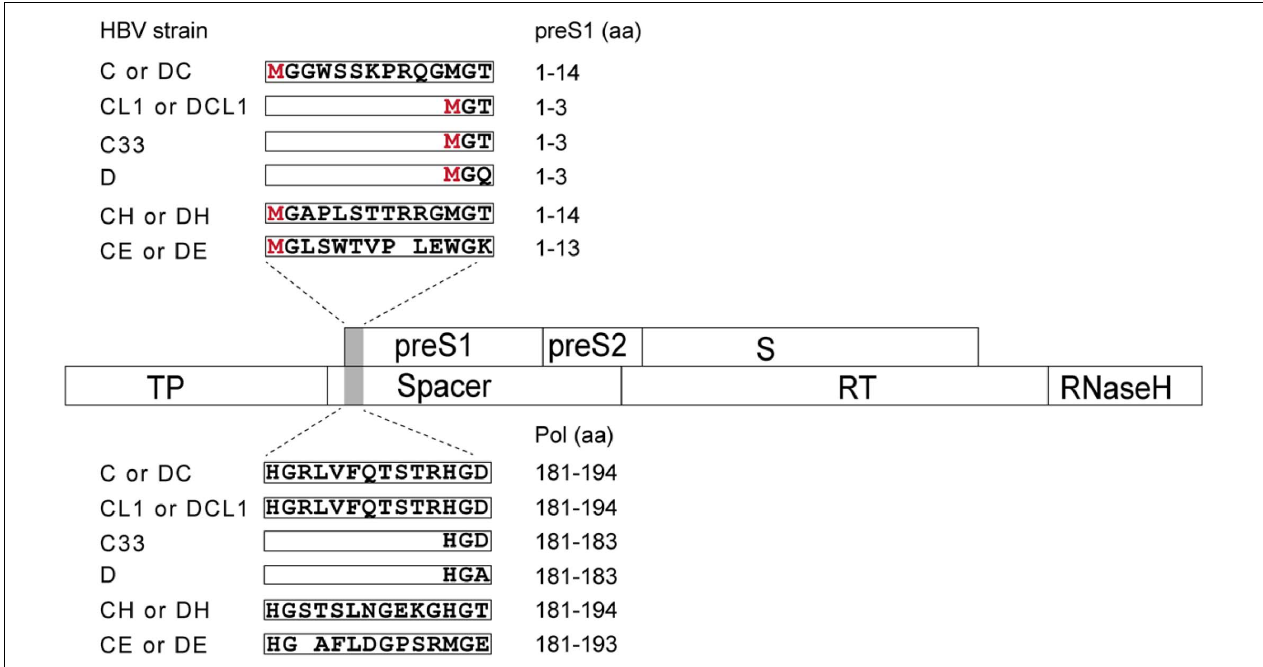
FIGURE 2 | Schematic representation of preS1 N-terminal sequences from C strain (GTC) or D strain (GTD) and their mutants in this study. Overlapping feature is showed between preS/S and Pol ORFs, which are indicated by open boxes. Mutated region is shaded by gray color. N-terminal sequences of preS1 are translated on the top in open boxes and corresponding Pol-spacer sequence are translated below. CL1 represents the C strain with mutated L1 from ATG into ACG, which shortens N-terminus of preS1 but changes no aa in spacer. C33 represents C with 33 nt deletion corresponding to 11 aa deletion at N terminus of preS1, which deletes 11 aa in both preS1 and spacer. CH and CE represent C with preS1 N-terminus substitution with H- and E-type, respectively. DC, DH and DE represent D with preS1 N-terminal insertion of C-, H- and E-type, respectively. DCL1 represents DC with mutated L1 from ATG into ACG, which recoveries preS1 N-terminus to D-type but extends spacer by 11 aa to make it as C-type. HBV, hepatitis B virus; preS, presurface; S, surface; TP, terminal protein; RT, reverse transcriptase; ORF, open reading frame; aa, amino